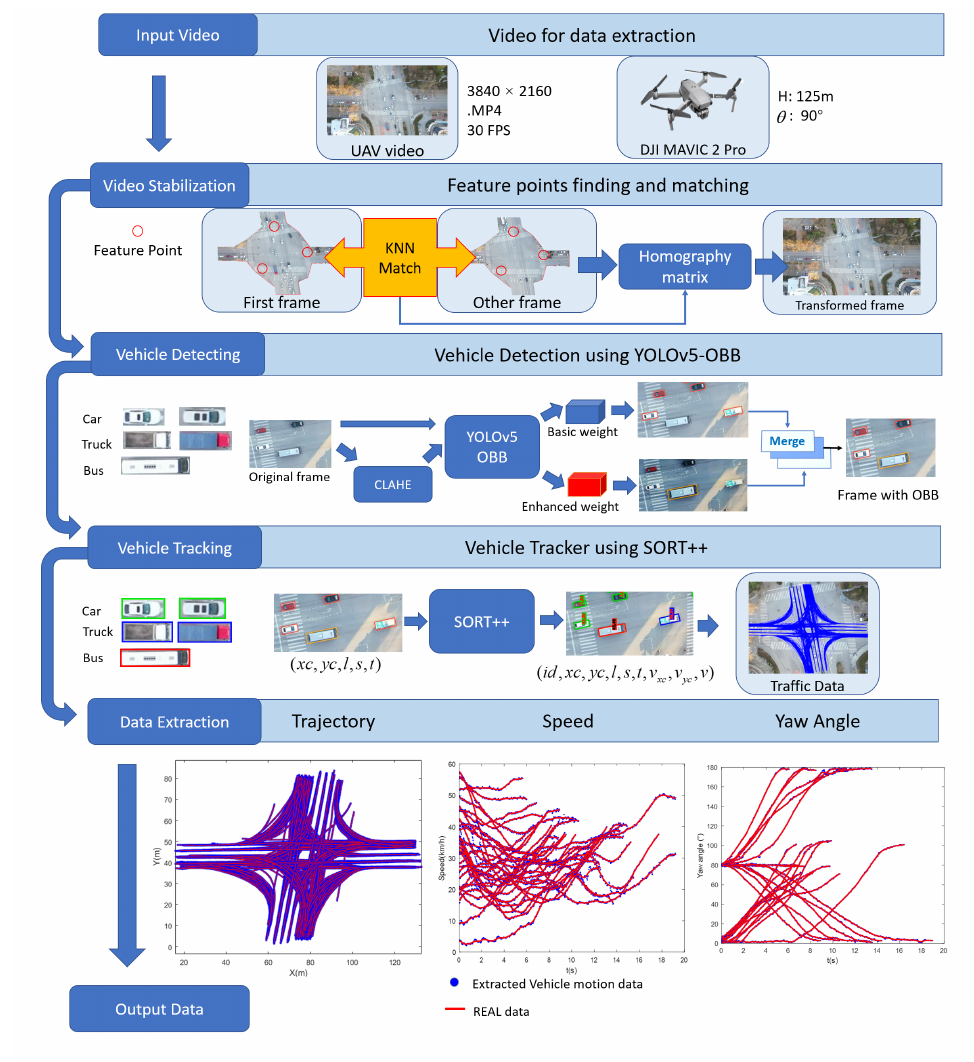
Figure 1. Framework flowchart for extracting vehicle motion data from UAV